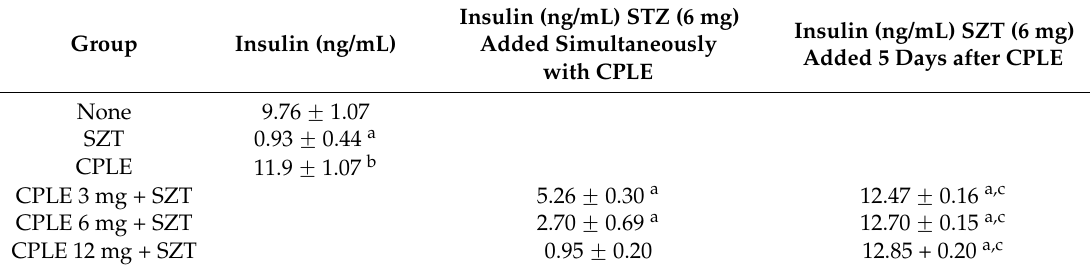
Table 1. Effect of the chloroform extract of C. papaya on insulin release from cultured β -cells.